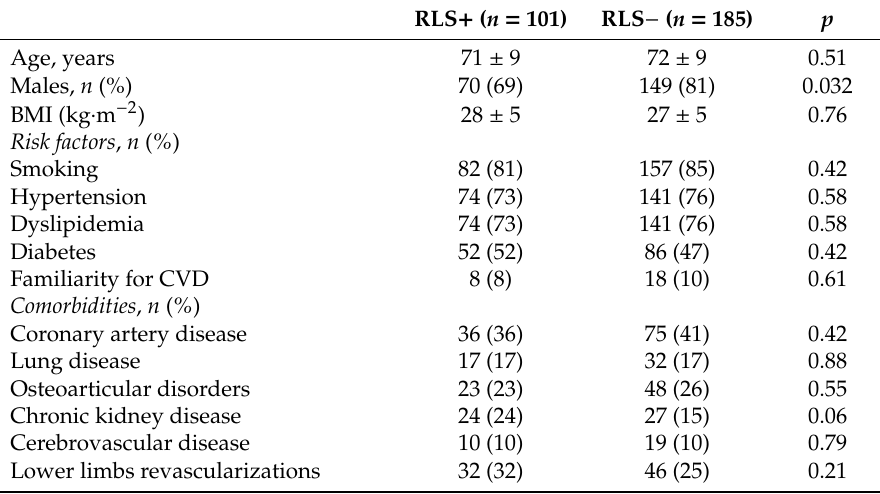
Table 2. Characteristics of the population included in the